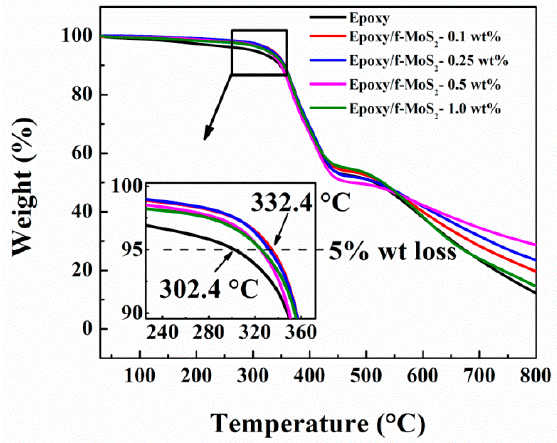
Figure 6. TGA curves of the Epoxy and Epoxy/f-MoS 2 nanocomposites. Table 1. Thermomechanical properties of the Epoxy and Epoxy/f-MoS 2 nanocomposites.